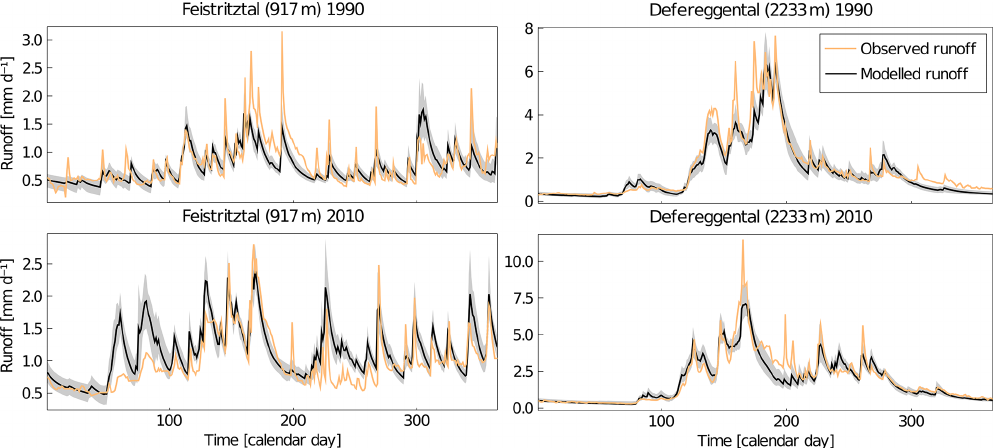
Figure 4. Comparison of measured and modeled runoff for 1 year during the calibration period (1990) and 1 year during the evaluation period (2010). The black line indicates mean modeled runoff using best parameter sets, and the shaded area corresponds to the range of best parameter